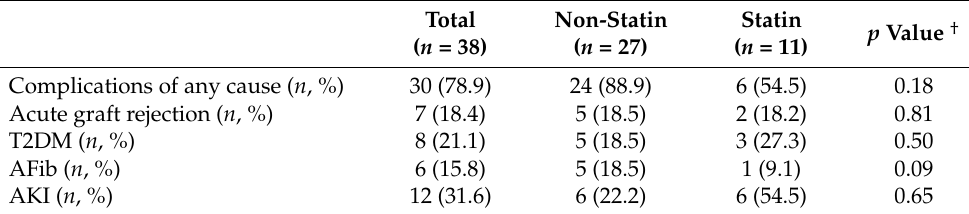
Table 2. Presence of complications of any cause/specific type of complications based on the group dis-